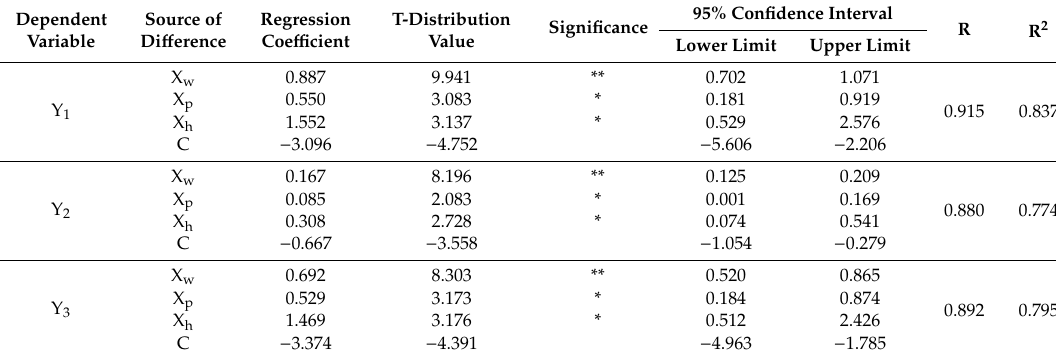
Table 6. The variance and regression analysis of the influence of three factors on edge drift distance, deposition center drift distance, and overlap width